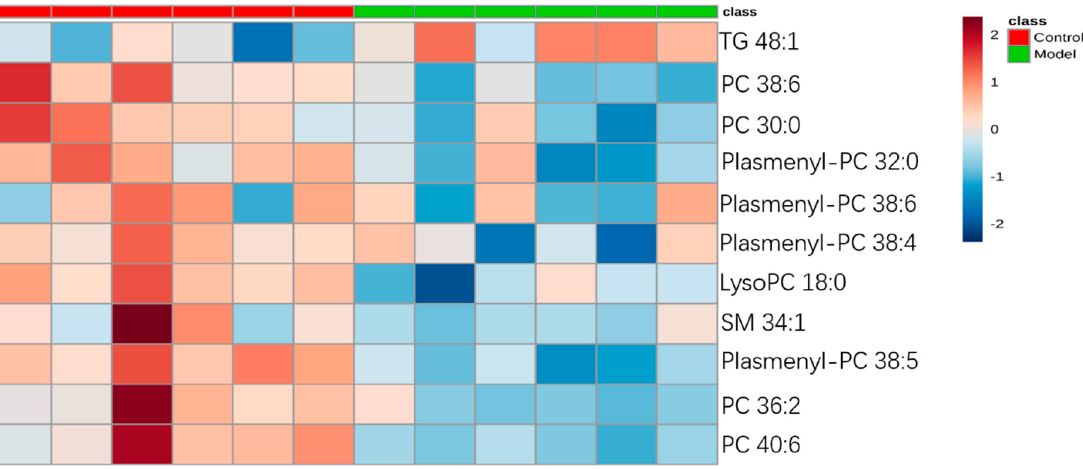
Figure 7. Box-whisker Plot of normalized peak intensity of differential lipids in BALF (negative ion mode) # p < 0.05, ## p < 0.01 vs. blank control mice.